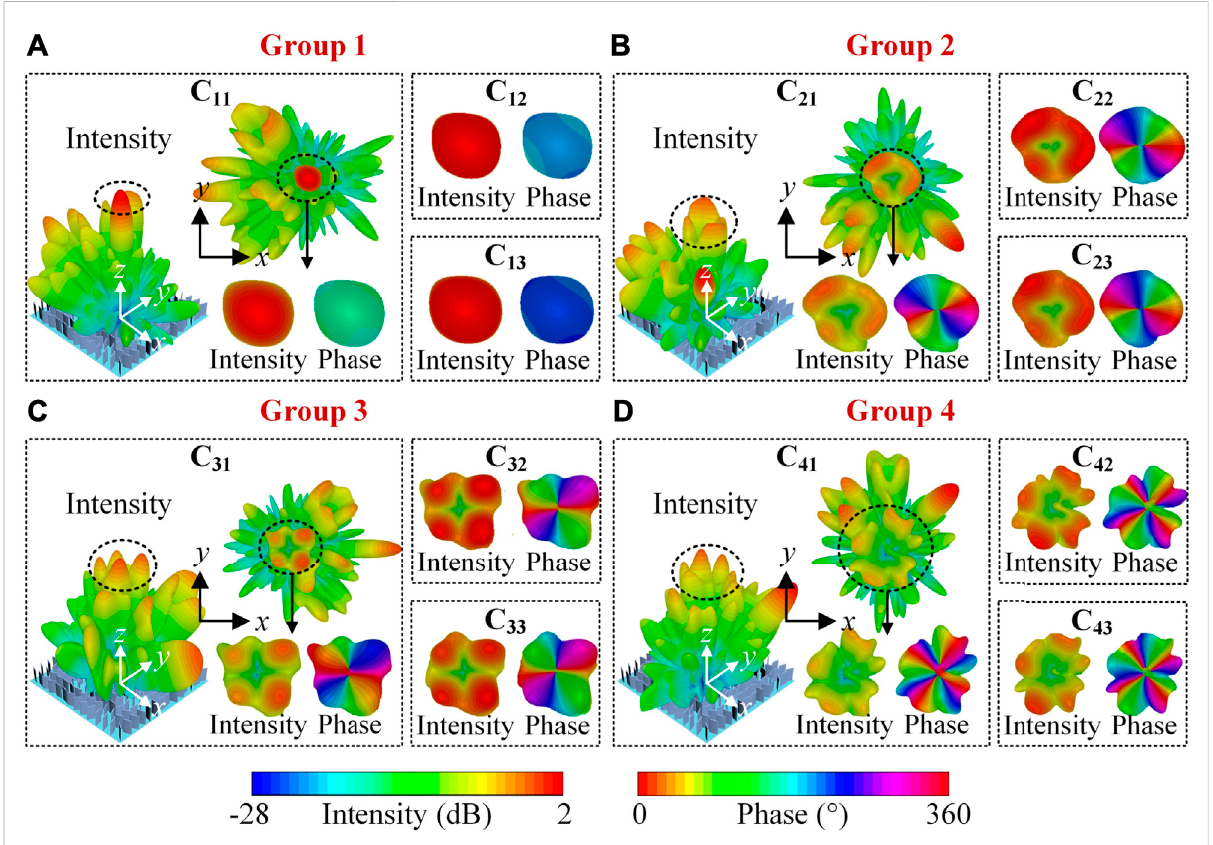
FIGURE 7 Simulated far fi eld patterns of the RCP transmitted wave. RCP transmitted waves are transformed into 3-channel orthogonal on-axis beams with different frequencies ( f 1 = 0.25 THz, f 2 = 0.3 THz, and f 3 = 0.35 THz) and the same topological charge (A) l 1 = 0 (B) l 2 = +2 (C) l 3 = -2 (D) l 4 = +4. Therefore, the 12-channel orthogonal on-axis beams with topological or frequency orthogonality can be achieved.